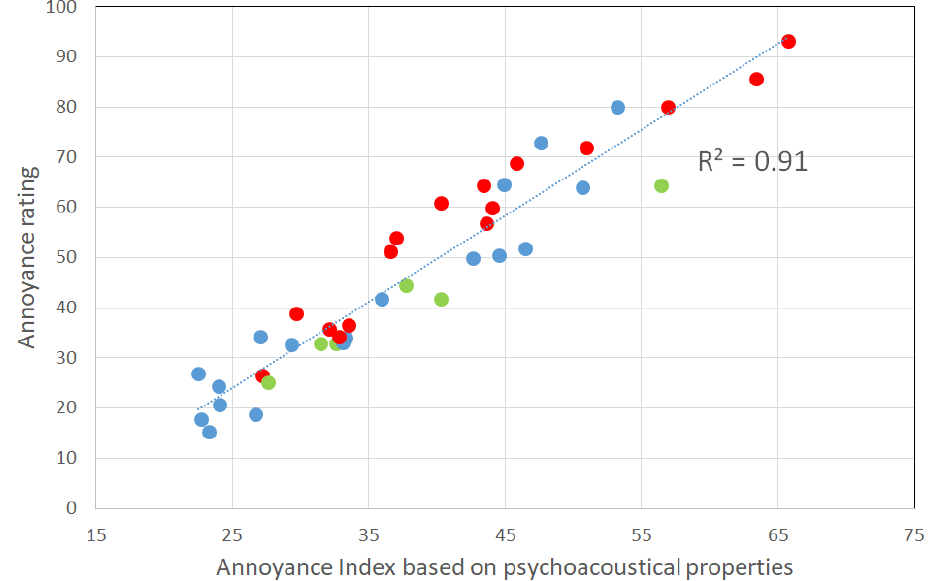
Figure 6. The relationship between perceived annoyance ratings and the developed annoyance index, which is based on psychoacoustical properties. (Red dots: ICE cars, green dots: hybrid cars, and blue dots: electric cars).